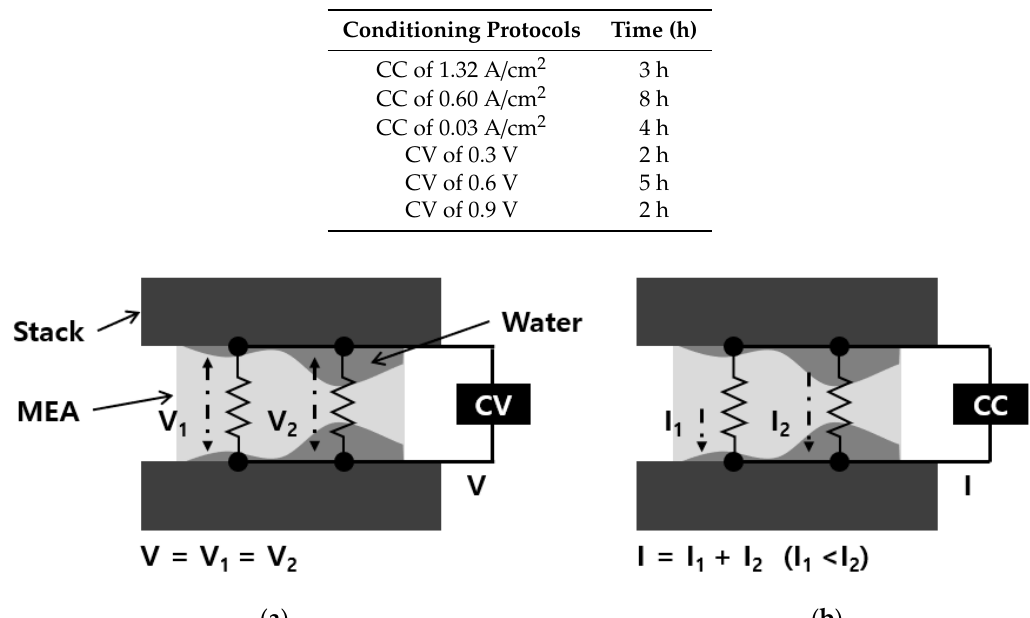
Figure 6. Principle of difference between ( a ) CV and ( b ) CC modes in the conditioning process. Table 2. Time required for complete conditioning.